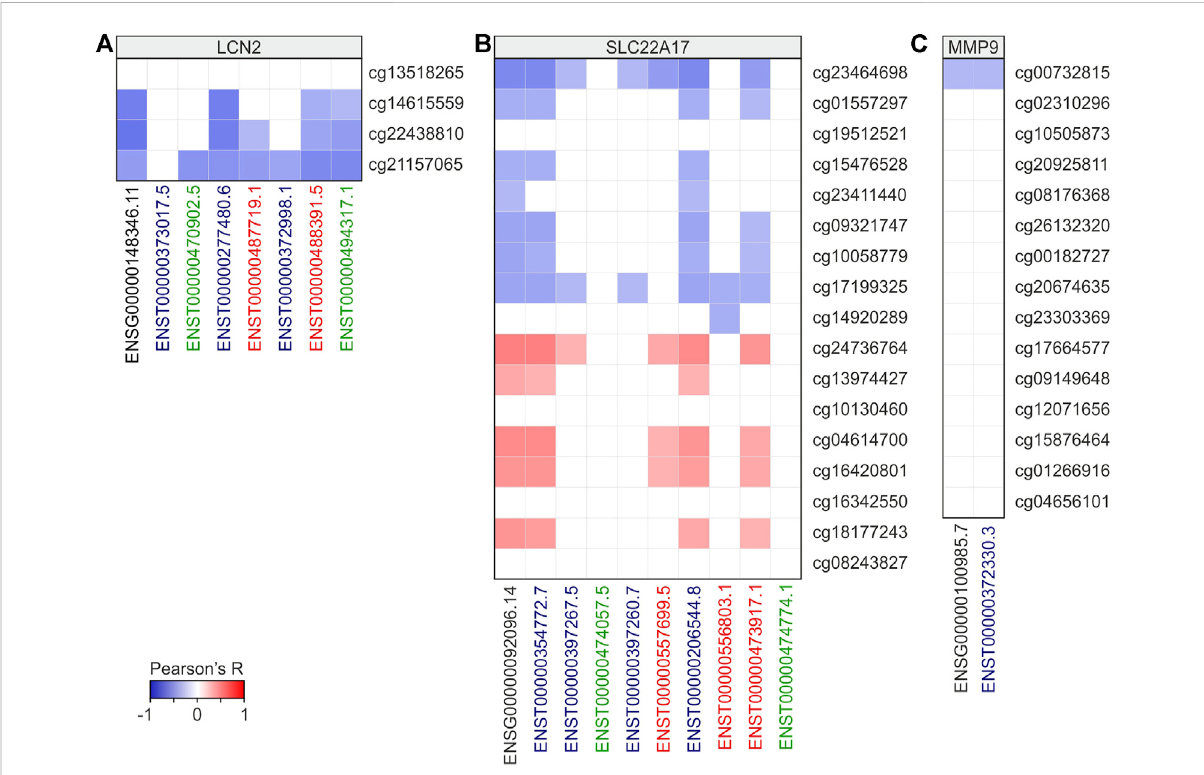
FIGURE 9 Correlation analysis between LCN2 (A) , SLC22A17 (B) , and MMP9 (C) gene/isoforms expression and CG probesets methylation levels in all tumors. Correlation with Pearson ’ s r ≥ 0.3 or ≤ − 0.3 and p ≤ 0.05 were included in the heatmap. Black bold labels indicate the LCN2 , SLC22A17 , and MMP9 genes (ENSG). Coding ENST isoforms: blue; non-coding ENST isoforms: green; retained intron ENST isoforms: